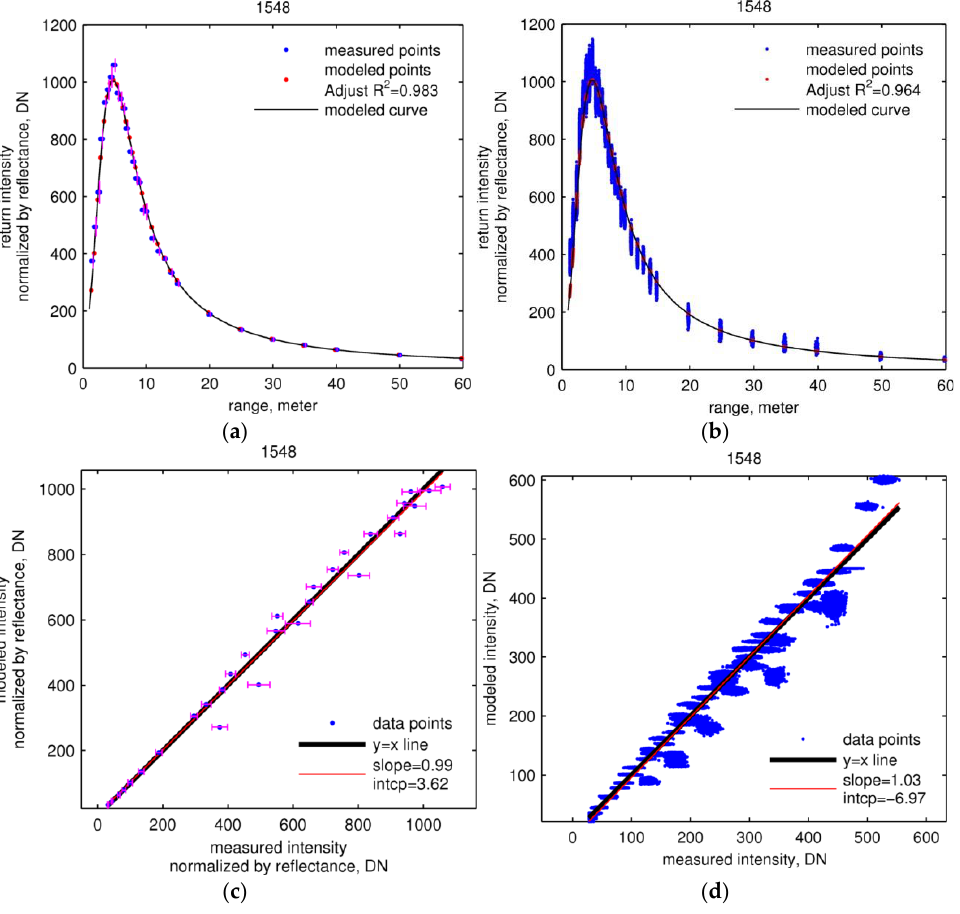
Figure 5. Estimation and validation of calibration of 1548 nm data. In both rows, the left column ( a,c ) shows the calibration function as fitted to training data, and the right column ( b,d ) shows the fit to the validation data. First row (a,b): measured and modeled intensity normalized by reflectance. Second row (c,d): scatter plots of measured against modeled intensity. The vertical error bars in (a) and horizontal error bars in (c) are one standard deviation of measured intensities normalized by reflectance. Table 4. Assessment of calibration fitting and validation.